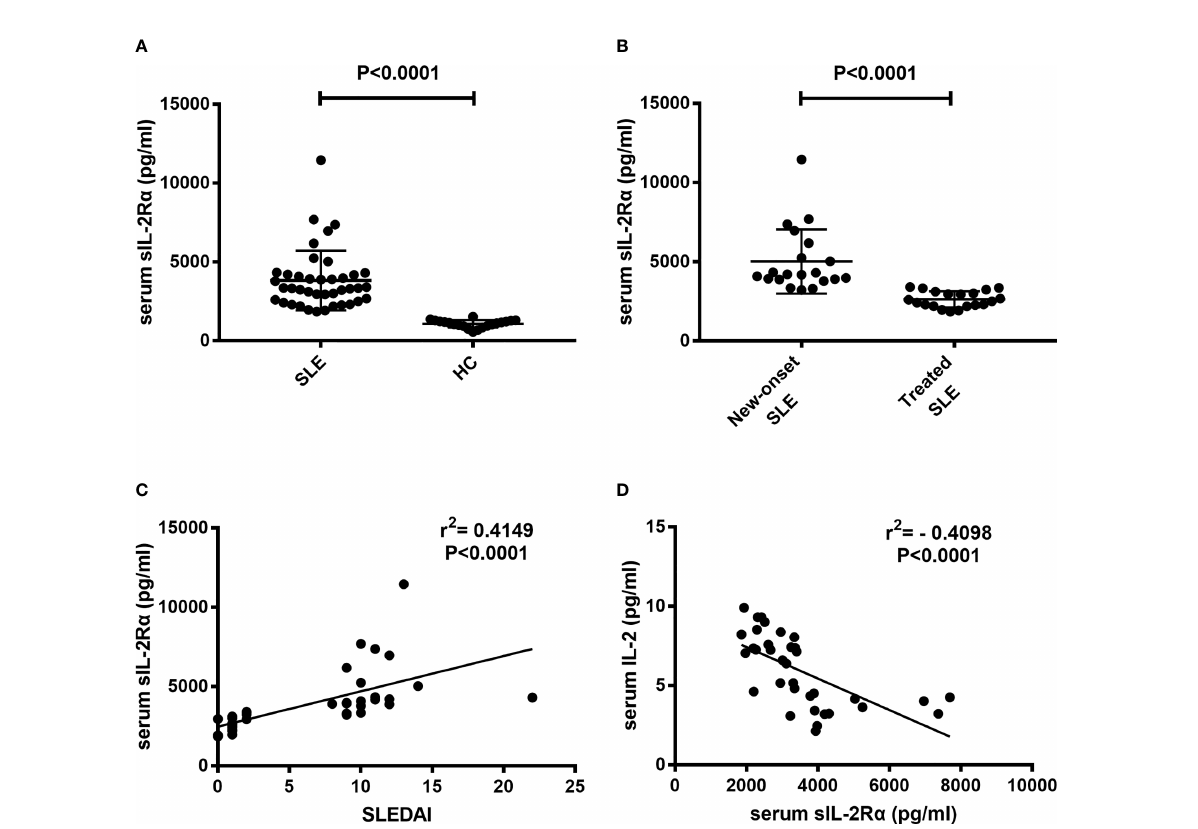
FIGURE 2 The levels of serum sIL-2R a in SLE patients were elevated and correlated with the SLEDAI and serum IL-2 levels. (A) Serum sIL-2R a levels in SLE patients were signi fi cantly higher than those in HCs. (B) Serum sIL-2R a levels in new-onset SLE patients were signi fi cantly higher than those in treated SLE patients. (C) There was a positive correlation between serum sIL-2R a and SLEDAI. (D) A negative correlation was observed between the levels of serum sIL-2R a and serum IL-2 in SLE